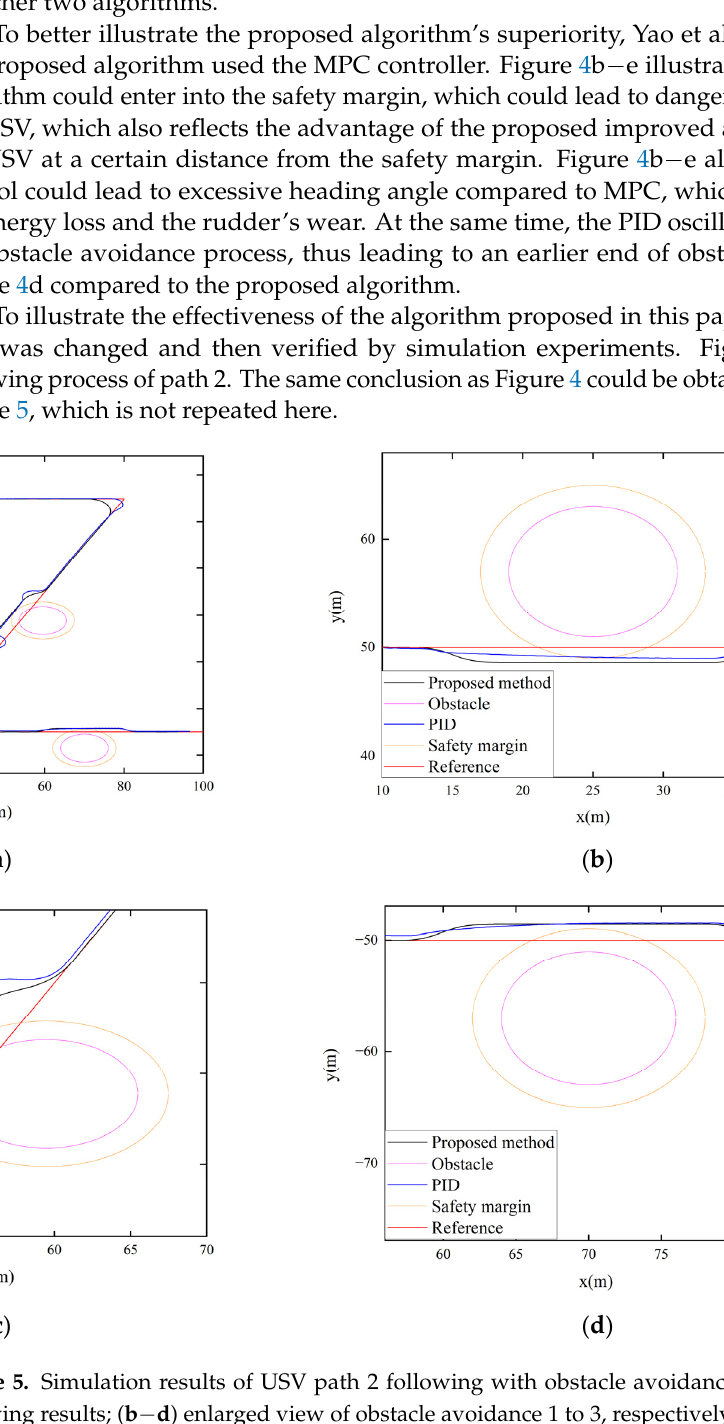
( b ) Figure 6. The yaw velocity of paths 1 and 2: ( a ) the yaw velocity of path 1; ( b ) the yaw velocity of path 2.